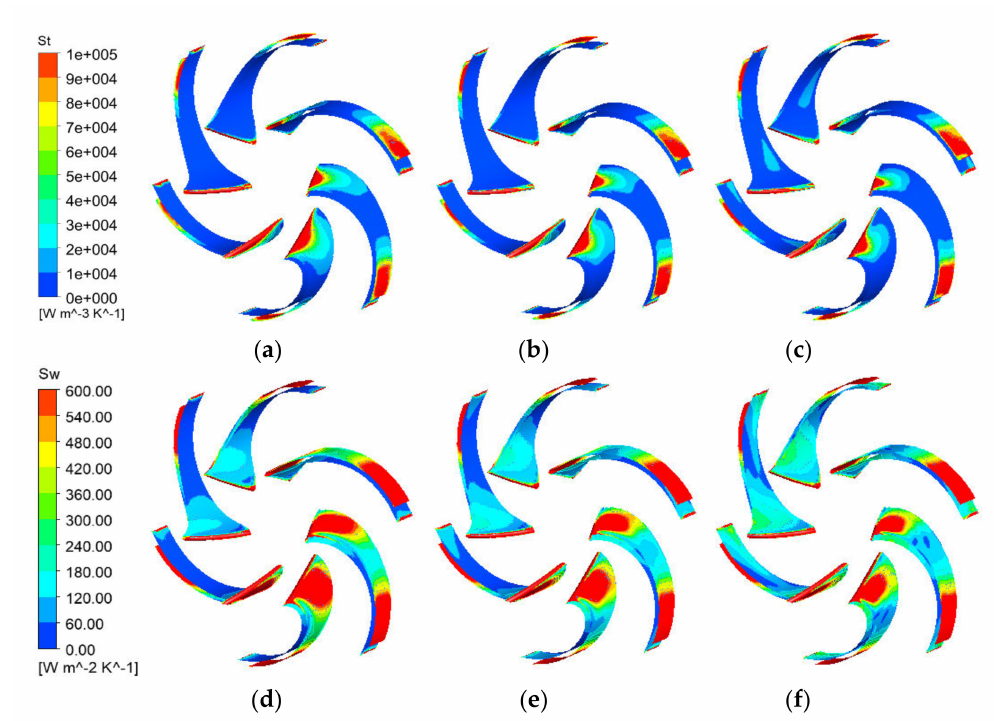
Figure 5. Entropy generation distribution of the impeller. Turbulent kinetic energy entropy: ( a ) 0.8 Q d ,